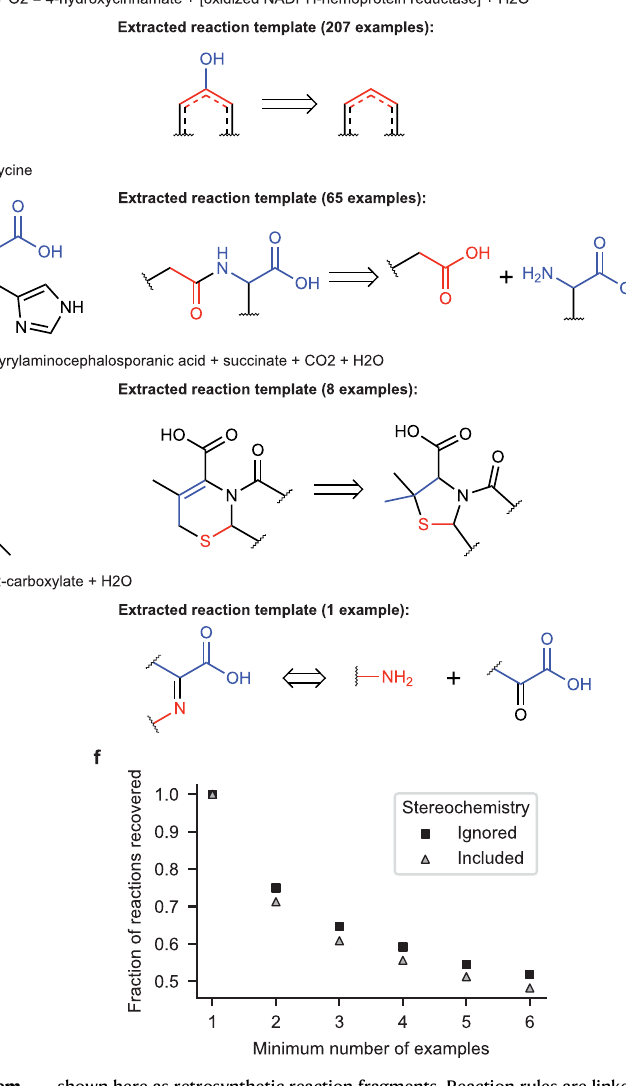
shown here as retrosynthetic reaction fragments. Reaction rules are linked to the reactiondatabase,sometadatasuchasassociated enzymesandECnumberforthe reaction can beeasily retrieved. e The numberof examples for a reactiontemplate in the reaction database as a function of the rank of the template ’ s popularity. f Fraction of the reactions in the BKMS database thatcan be described by reaction templates that have greater than a threshold number of